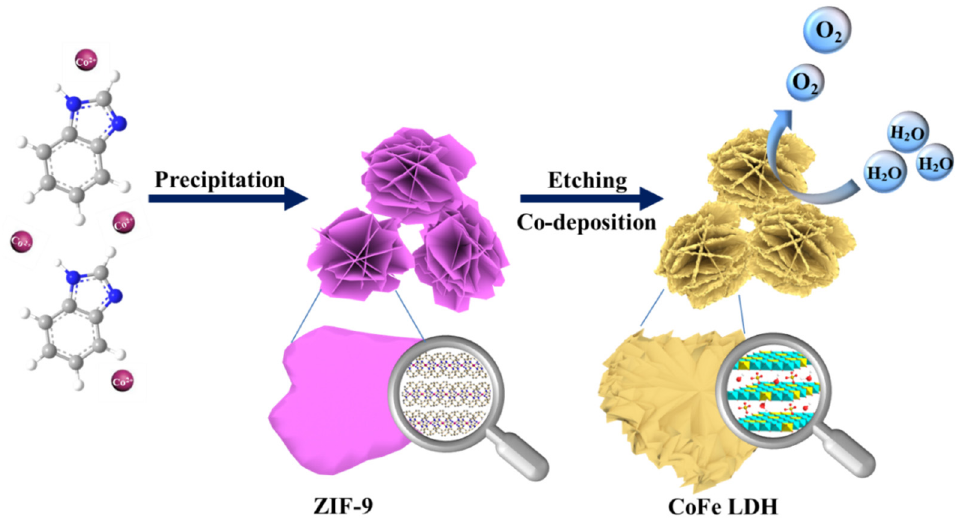
Figure 1. Schematic illustration of the synthetic procedure of CoFe LDH nanosheets.